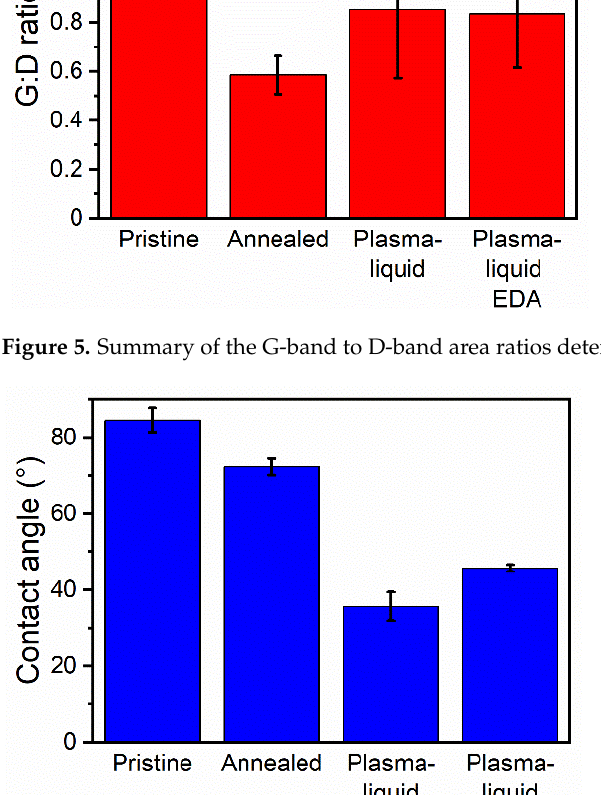
Figure 5. Summary of the G-band to D-band area ratios determined by Raman spectroscopy.